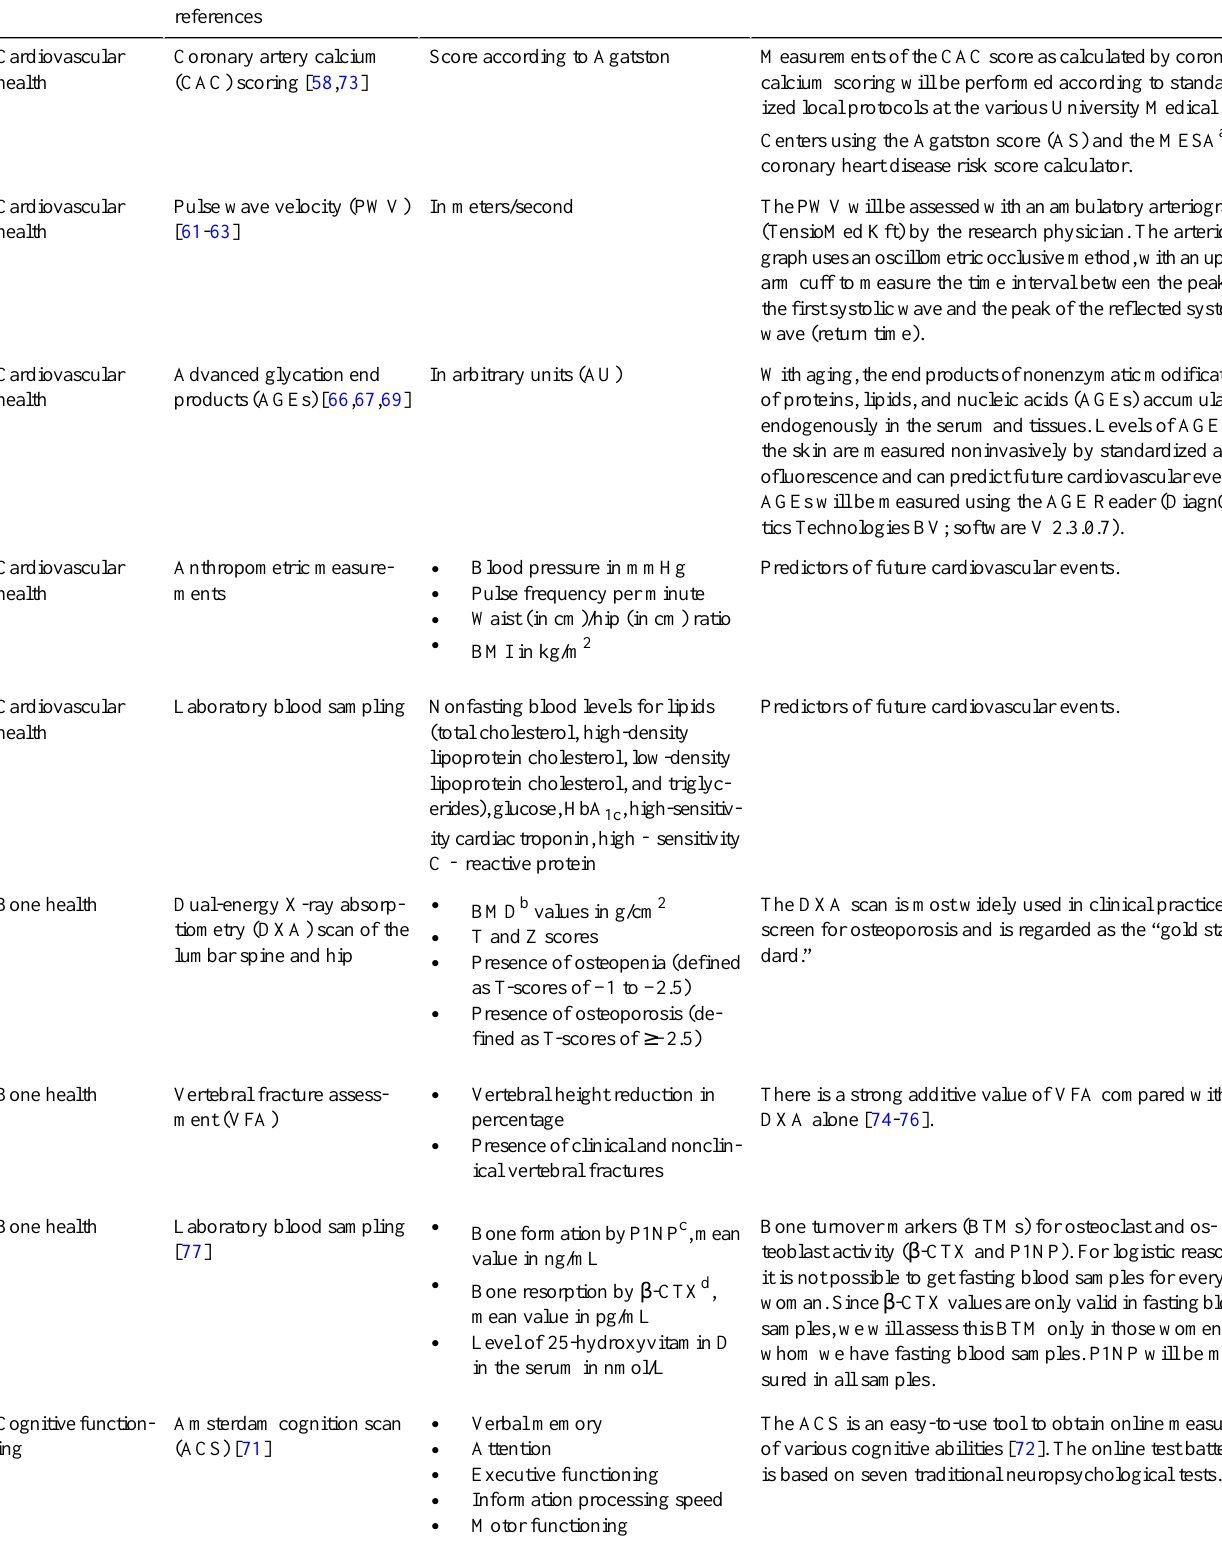
Table 1. Overview of the tests that will be performed. JustificationOutcome variablesData collection method and referencesAim of the test Measurements of the CAC score as calculated by coronary calculator.Score according to AgatstonCoronary artery calcium [58,73]Cardiovascular calcium scoring will be performed according to standard- (CAC) scoring health ized local protocols at the various University Medical Centers using the Agatston score (AS) and the MESA a coronary heart disease risk score The PWV will be assessed with an ambulatory arteriograph meters/secondPulse wave velocity (PWV) [61-63]Cardiovascular (TensioMed Kft) by the research physician. The arterio- health graph uses an oscillometric occlusive method, with an upper arm cuff to measure the time interval between the peak of the first systolic wave and the peak of the reflected systolic wave (return With aging, the end products of nonenzymatic modification of proteins, lipids, and nucleic acids (AGEs) accumulate endogenously in the serum and tissues. Levels of AGEs in the skin are measured noninvasively by standardized aut- ofluorescence and can predict future cardiovascular events. AGEs will be measured using the AGE Reader (DiagnOp- tics Technologies BV; software